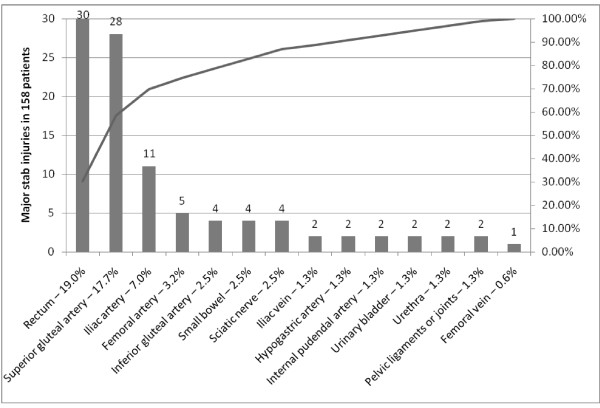
Types of major injury related to stab trauma to the buttock in 158 patients.